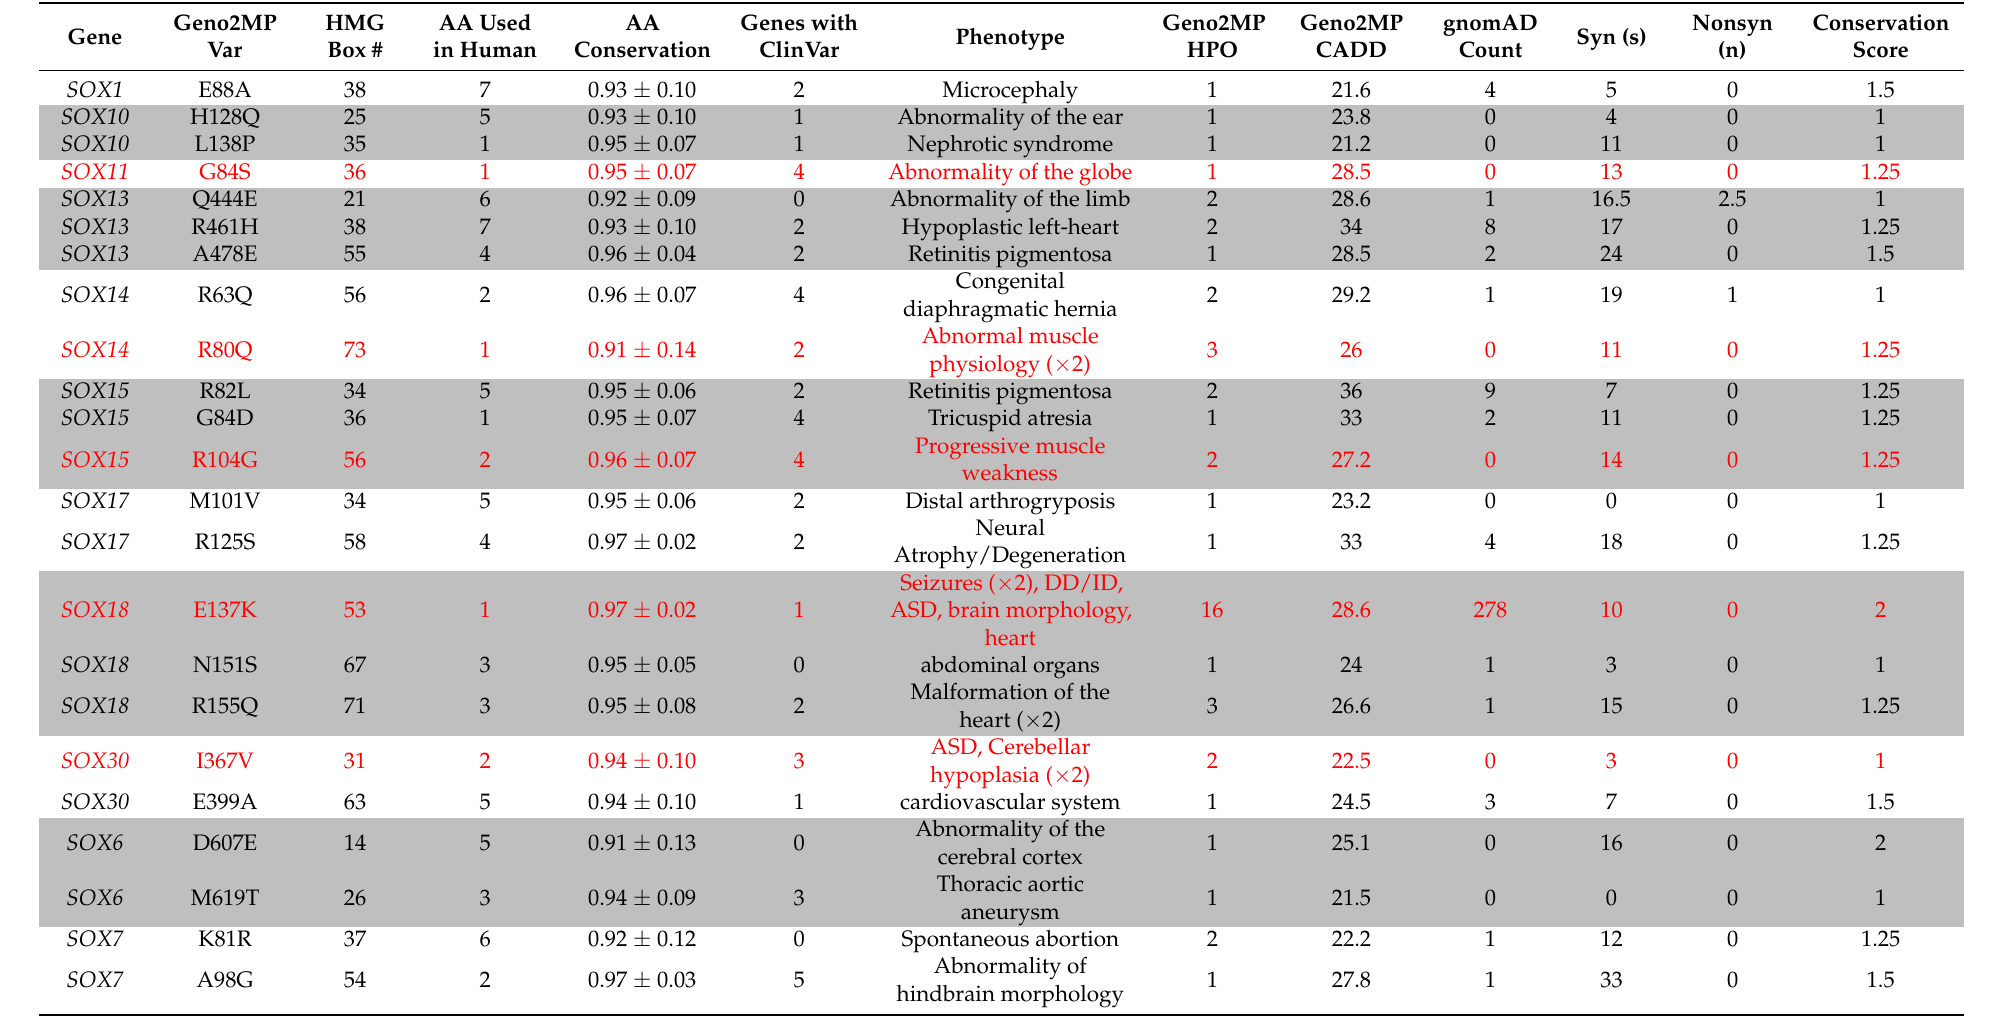
Table 4. Geno2MP variants within the HMG box using UniProt numbering. Those in red have matching phenotypes to the gene OMIM or in multiple Geno2MP individuals. Rotating white to gray indicates different SOX genes with multiple variants for